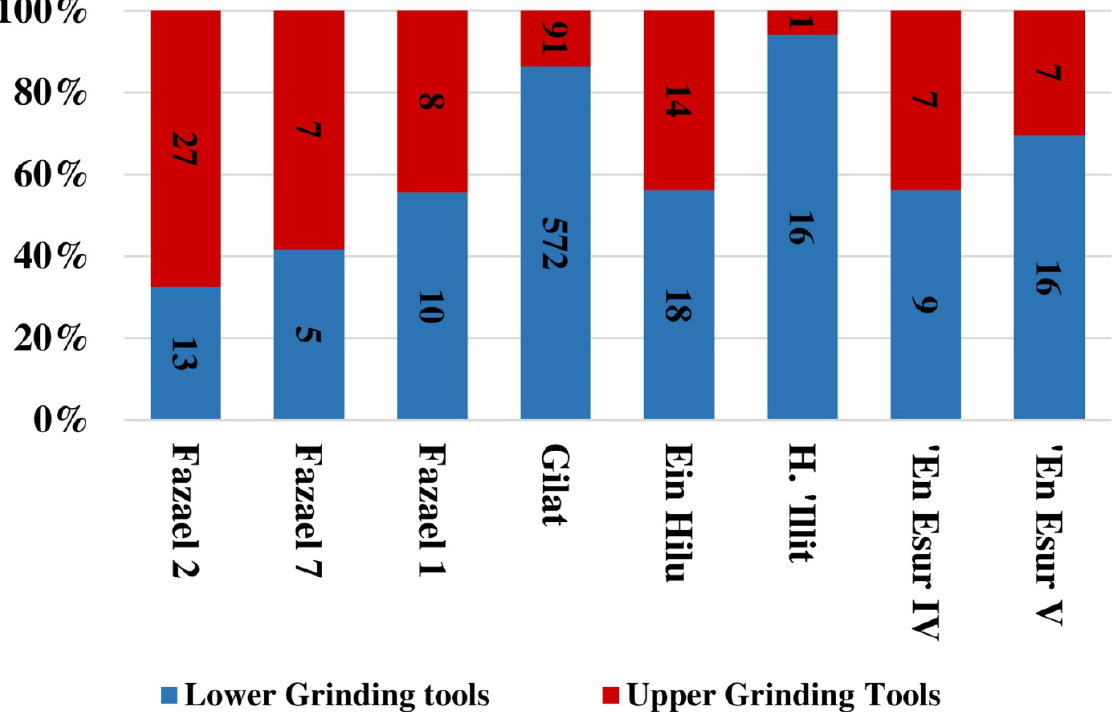
Figure 11. Frequency and quantities of lower and upper grinding tools in the Fazael sites, compared with other Late Chalcolithic sites (Rowan 2006; Rowan et al . 2006; Bar et al . 2008; Bar et al .